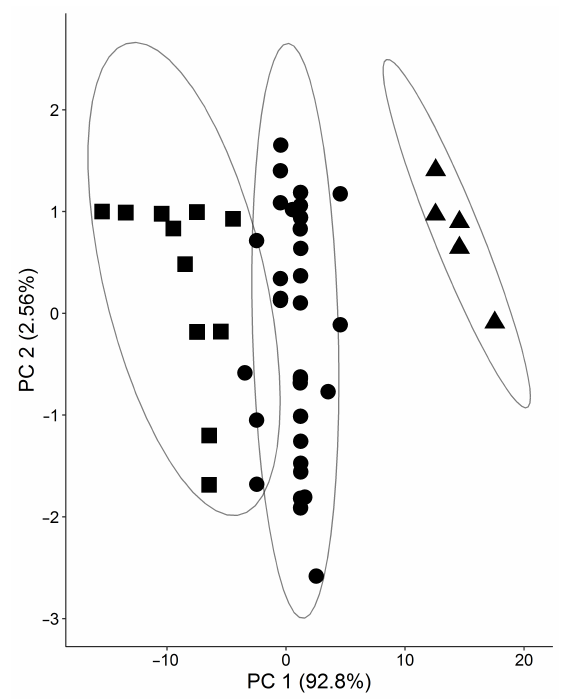
Figure 3. Principle component plot separating 48 T2DM patients in three clusters based on all available patient information, i.e., diagnostic parameters and glycated peptide levels. Missing values were imputed using Weka. The ellipses are drawn at the 95% confidence interval using the level parameter in the ggplot. PC1 and PC2 denote first and second principle components,